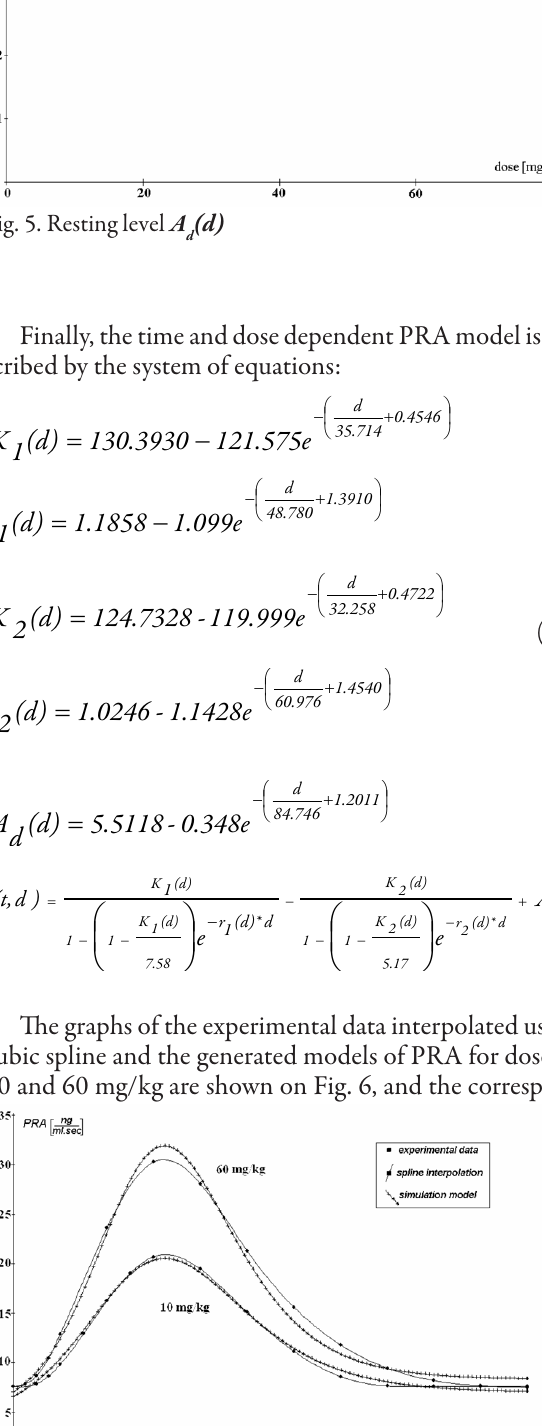
(d) and decrease rate r 1